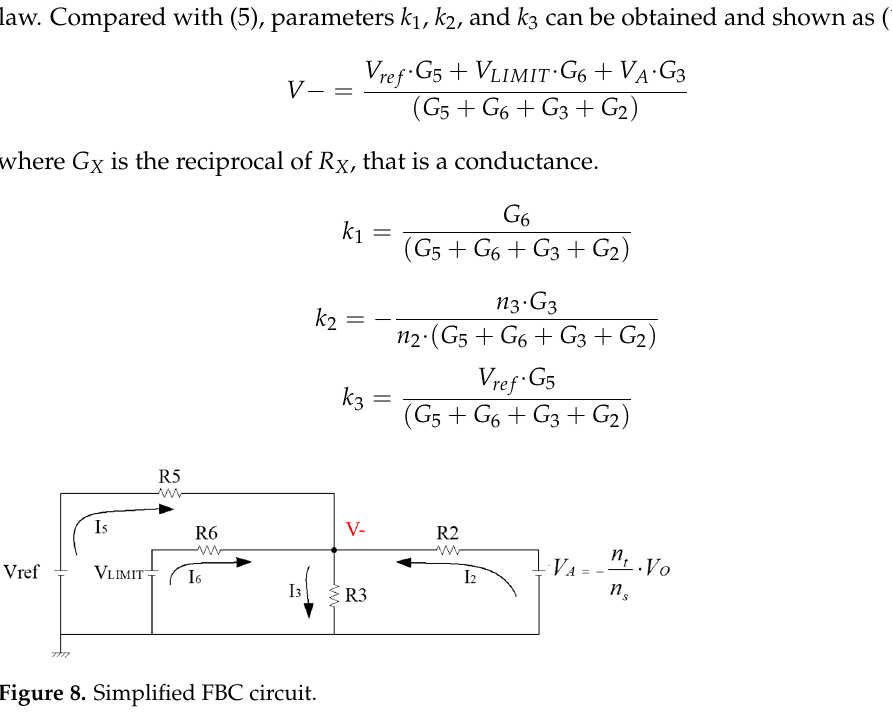
Figure 7. Circuit diagram of the proposed compensated peak current mode controlled PWM method.